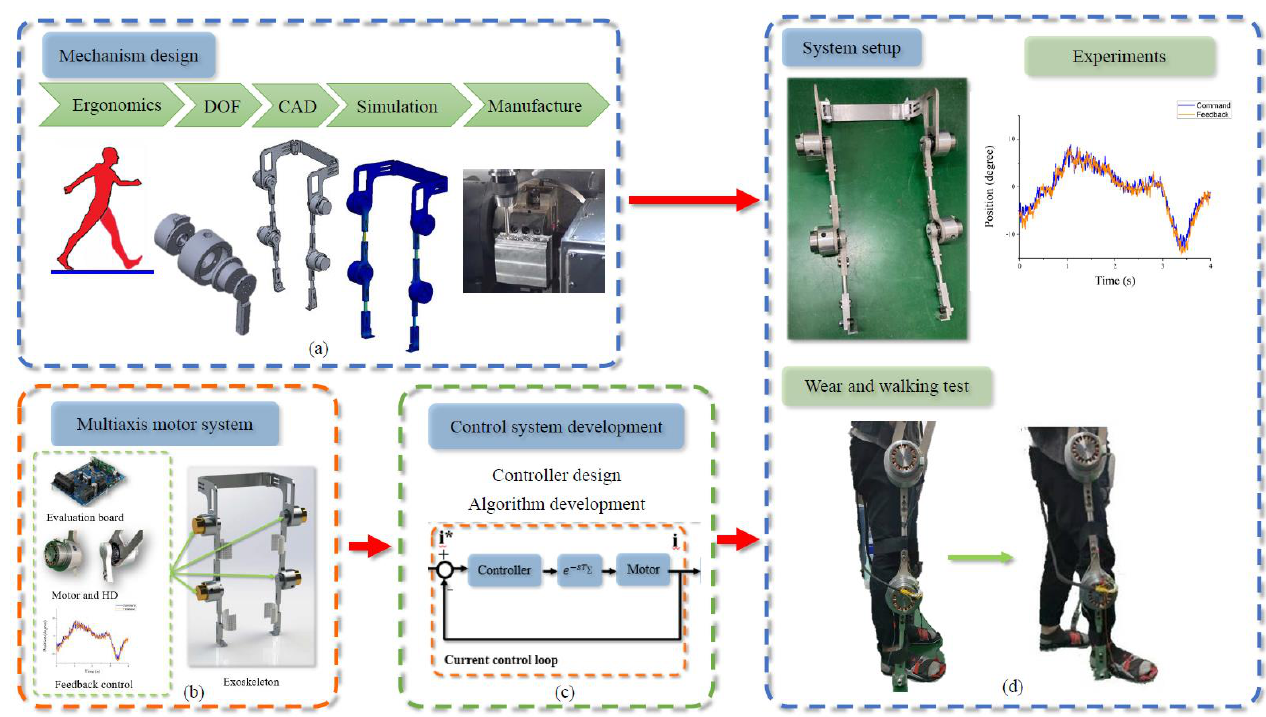
Figure 1. Study design of the LLRE-II. ( a ) Mechanical design, ( b ) multiaxis motor system, ( c ) control system development, and ( d ) system setup.